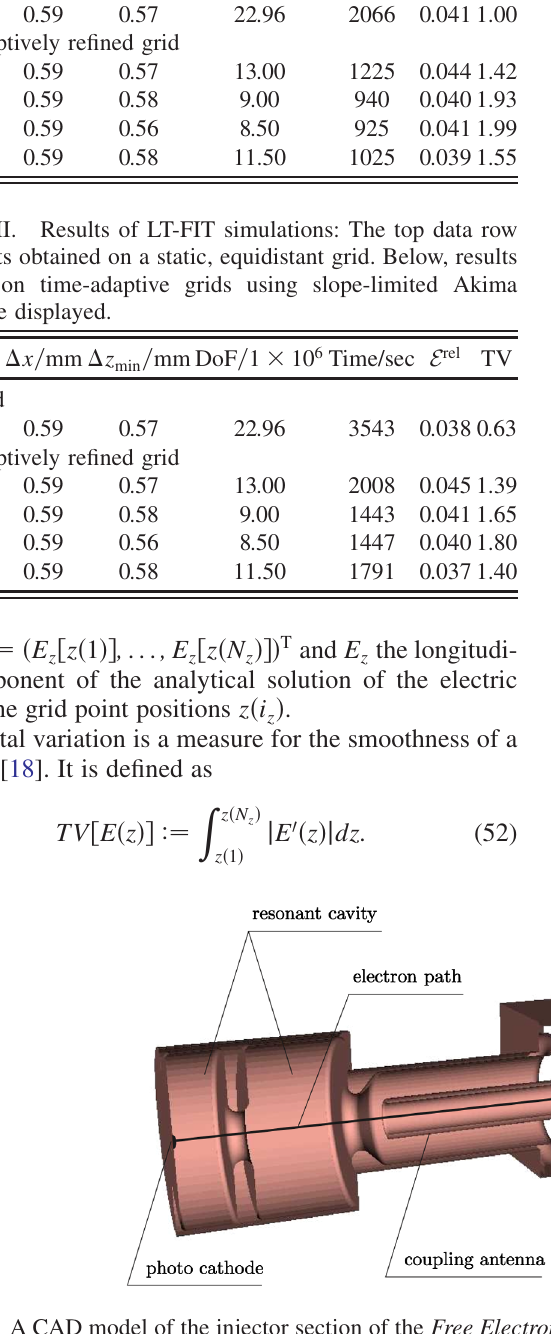
FIG. 11. A CAD model of the injector section of the Free Electron Laser in Hamburg (FLASH) is shown in cut view. The depicted part corresponds to approximately 60 cm of the injector. In total 2 m have been modeled. However, the nondepicted part consists only of the beam pipe. A short laser pulse is directed onto the photocathode, where electrons are emitted. The bunch of electrons is accelerated by a high-frequency electromagnetic field, which is excited in the resonant cavity. It propagates along the electron path through the coupling antenna and passes the shutter valve and the laser mirror, which is inserted through one arm of the diagnostics section. The other arms are used for inserting measurement devices. The opening on its bottom side is connected to a vacuum